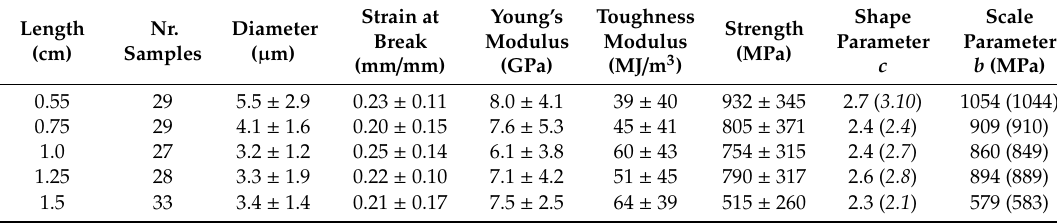
Figure 2. ( a ) The diameter of the dragline vs the length of the sample. ( b ) Strength of the dragline vs the length of the sample. ( c ) Linear regression plot of the strength data set used to compute the Weibull parameters. ( d ) Weibull’s probability density distribution of the strength at di ff erent lengths. ( e ) Shape parameter vs length of the sample. ( f ) Plot of Equation (6) with linear regression to compute the Weibull fractal dimension. Table 3. Mechanical properties and Weibull parameters of the dragline silk at di ff erent lengths. In italics and between brackets are the Weibull parameters obtained through the maximum likelihood method, following Peterlik [36].